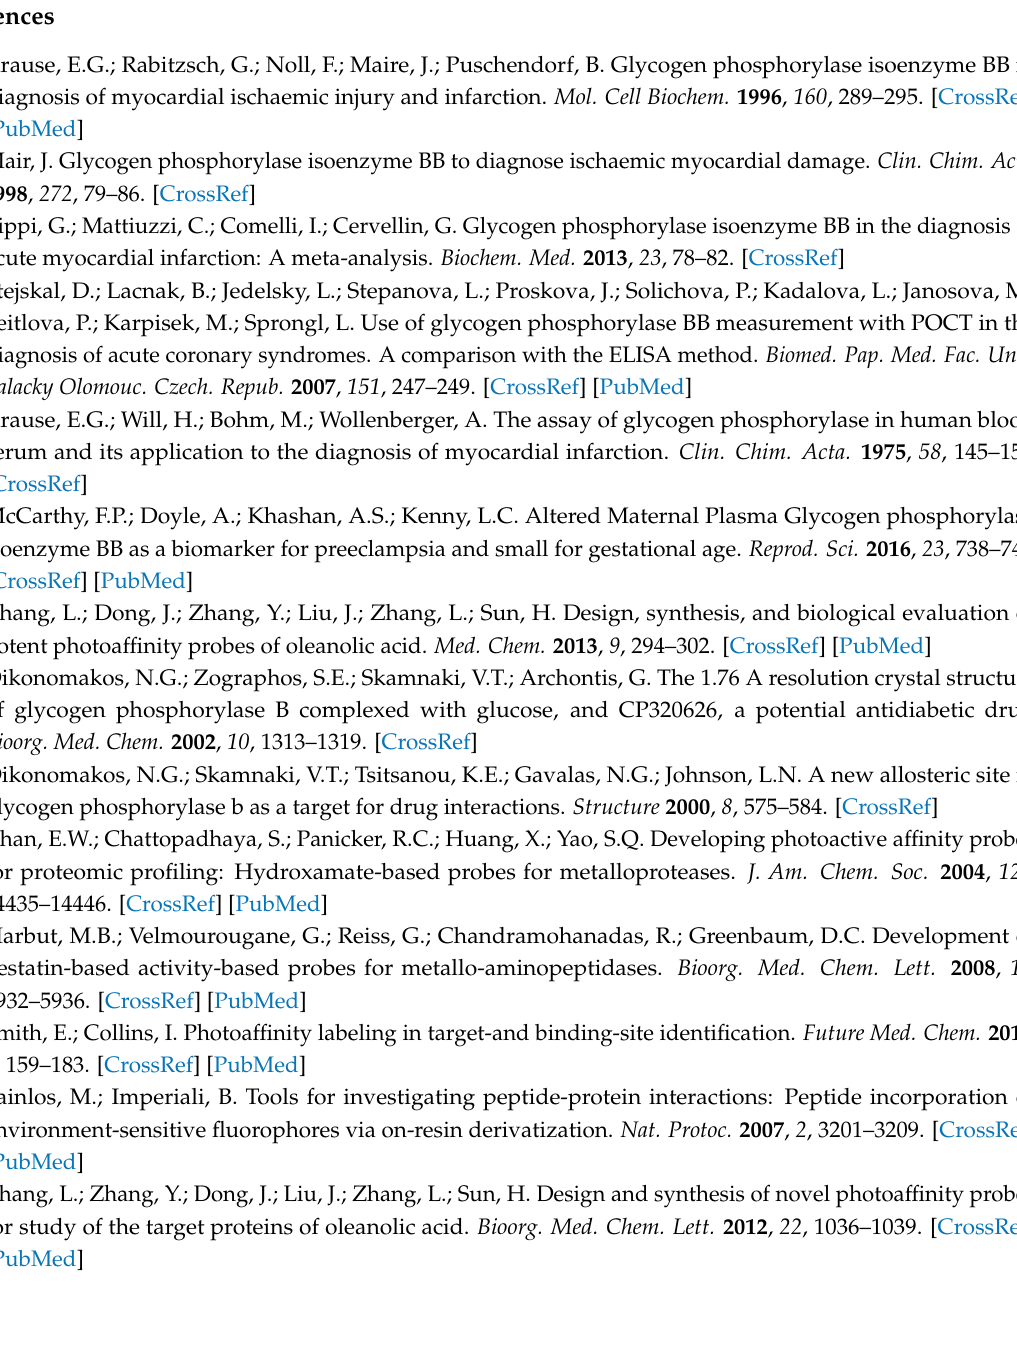
Figure S1–S11: Data and NMR spectra of the prepared